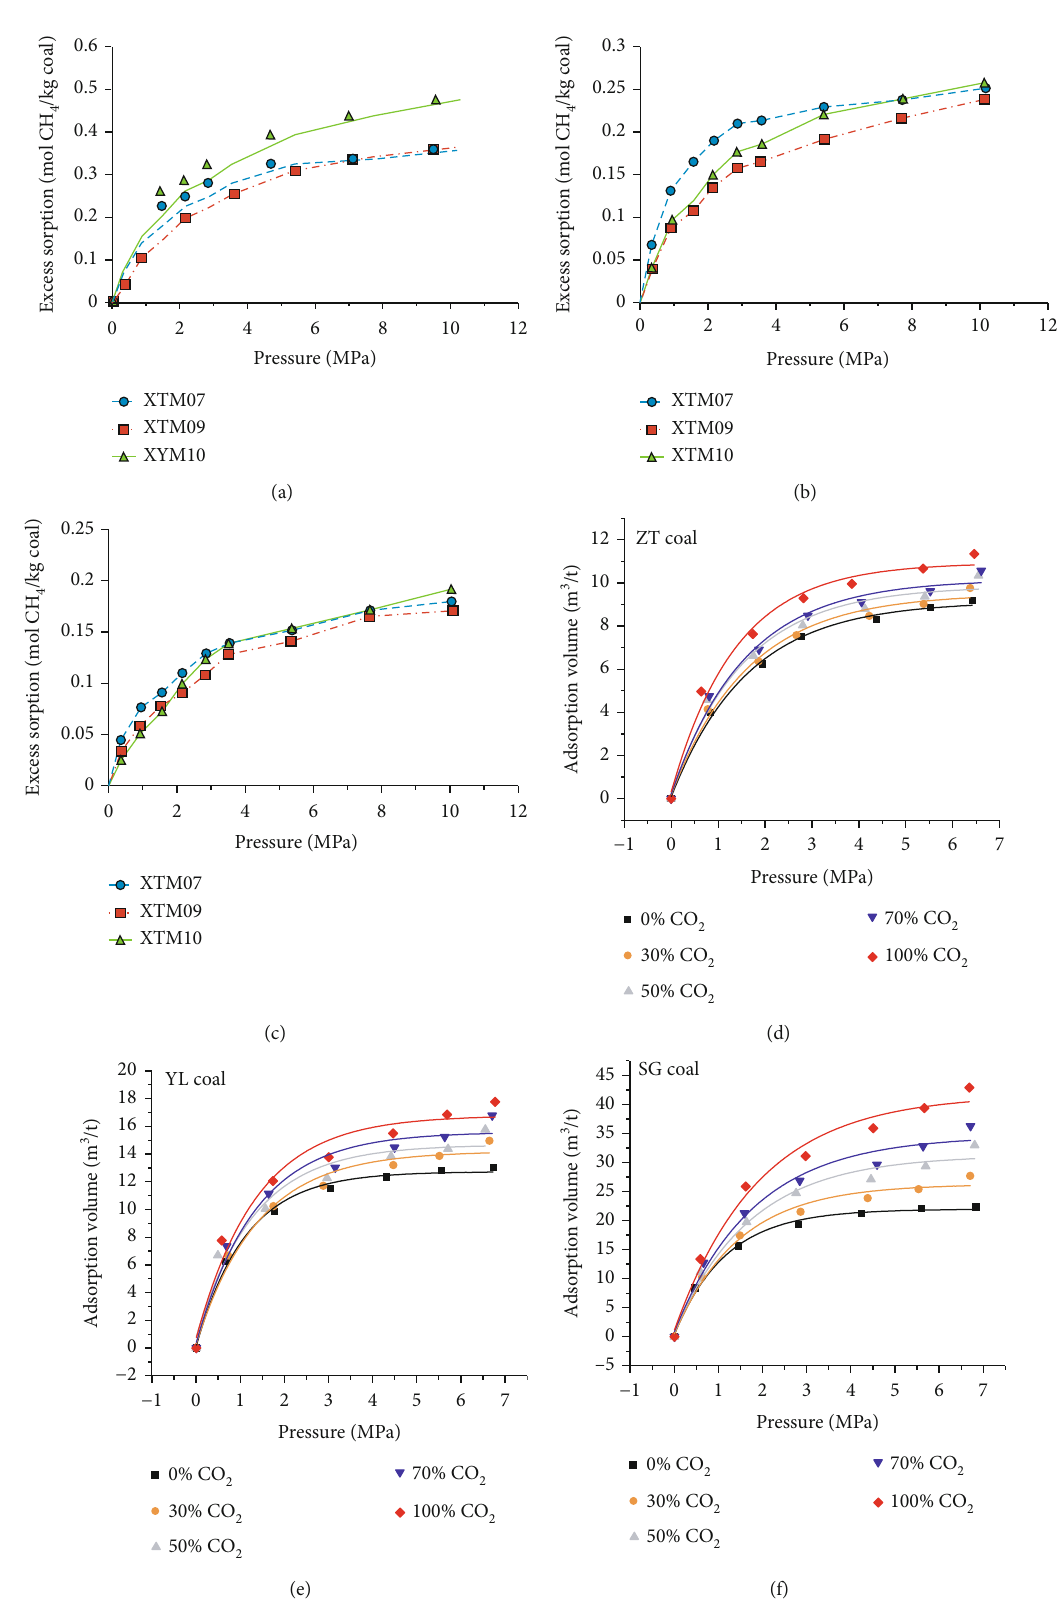
Figure 17: Variations of gas adsorption behavior with pressure in coal reservoirs: (a – c) adsorption isotherms of tectonically deformed coals at di ff erent temperatures; (d – f) isothermal adsorption curves of coals with di ff erent adsorbed gases (modi fi ed from Pan et al. [108] and Cai et al.